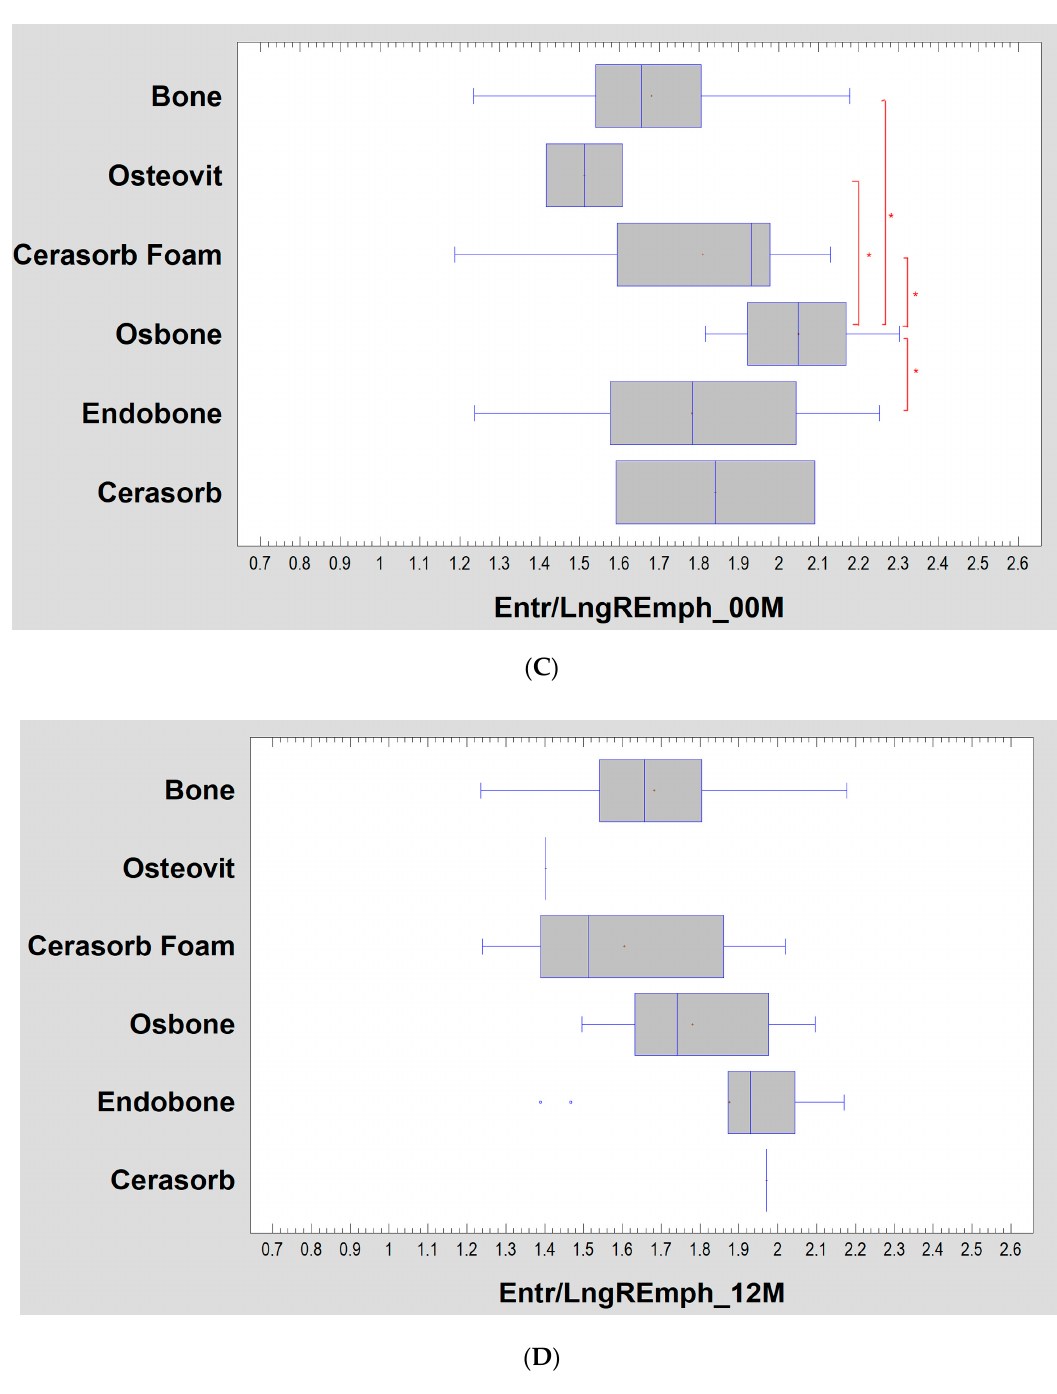
Figure 3. ( A ) Bone substitute-dependent alteration of radiotexture defined by the texture index in the implantation site. Observation immediately post-operation. Asterisks indicate a statistically significant difference ( p < 0.05). ( B ) Bone substitute dependent-alteration of radiotexture defined by the texture index in the implantation site. Observation 12 months post-operation. Asterisks indicate a statistically significant difference ( p < 0.05). ( C ) Bone substitute-dependent alteration of radiotexture defined by the texture index in the implantation site in a group of women >50 years old. Observation immediately post-operation. Asterisks indicate a statistically significant difference ( p < 0.05). ( D ) Bone substitute-dependent alteration of radiotexture defined by the texture index in the implantation site in a group of women >50 years old. Observation 12 months post-operation. No statistically significant differences found.